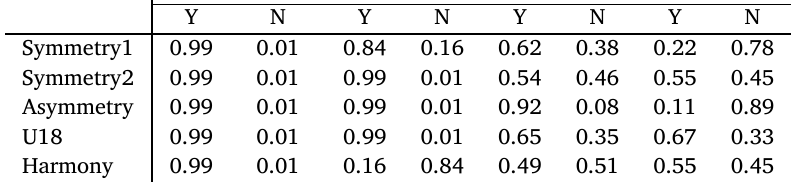
Table 10: Confusion Matrix of Naive Bayes classifier for Cysouw’s model. Table 11: Dryer’s joint probability Naive Bayes